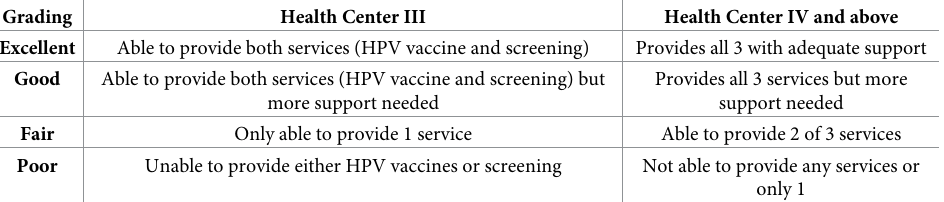
Table 1. Grading guidelines for health facilities based on Strategic Plan